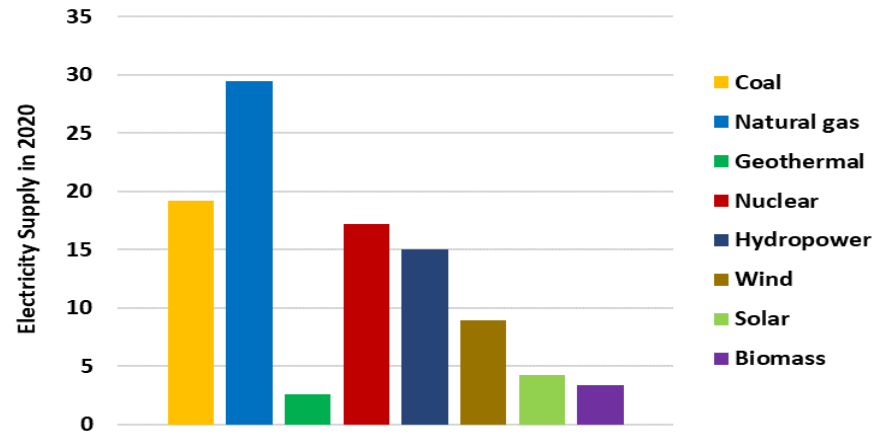
Figure 5. Changes in electricity generation in the year 2020.